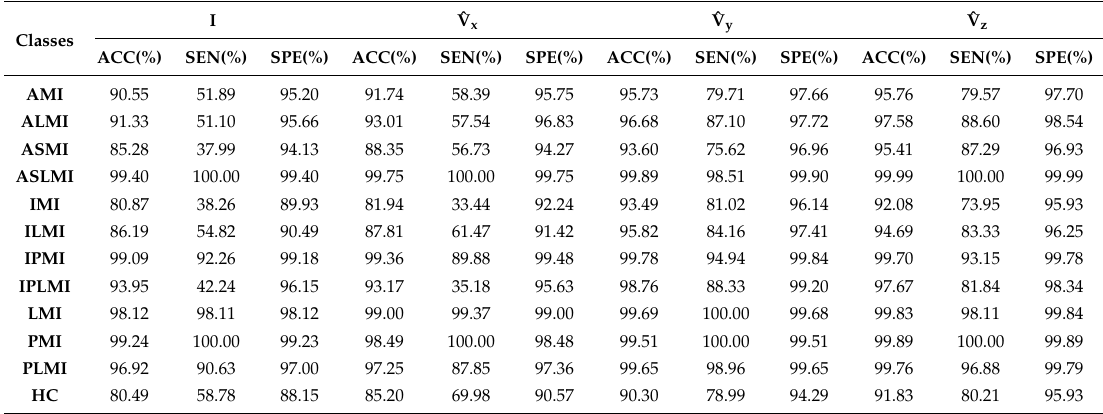
Table 4. Classification results of MLP classifier with single-lead signal.